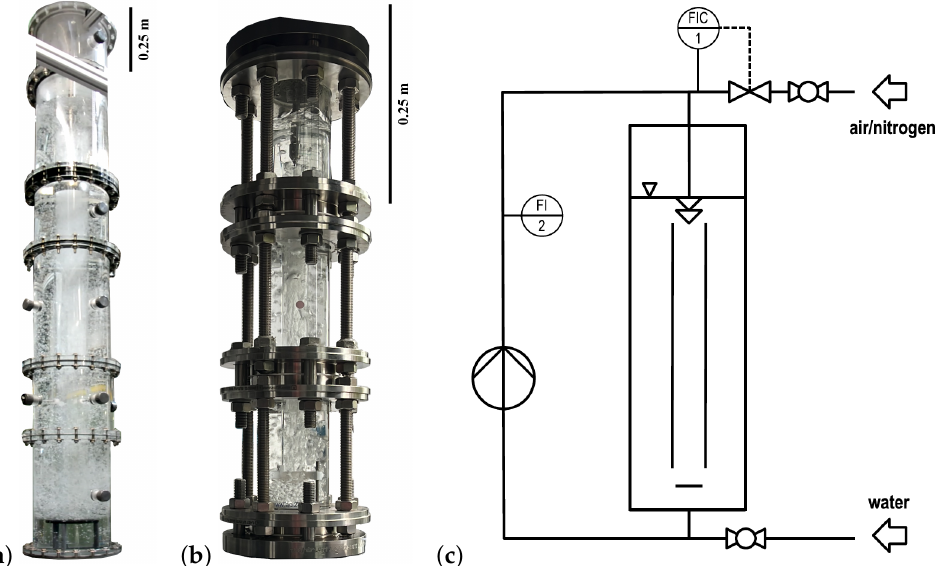
Figure 2. Photographs of ( a ) the pilot scale reactor and ( b ) the laboratory reactor as used for ex- periments at IMS and on site of the project partner. ( c ) Process flow diagram of the setups at